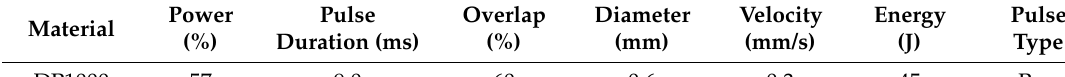
Table 4. Optimal welding parameters of DP 1000 steel used.